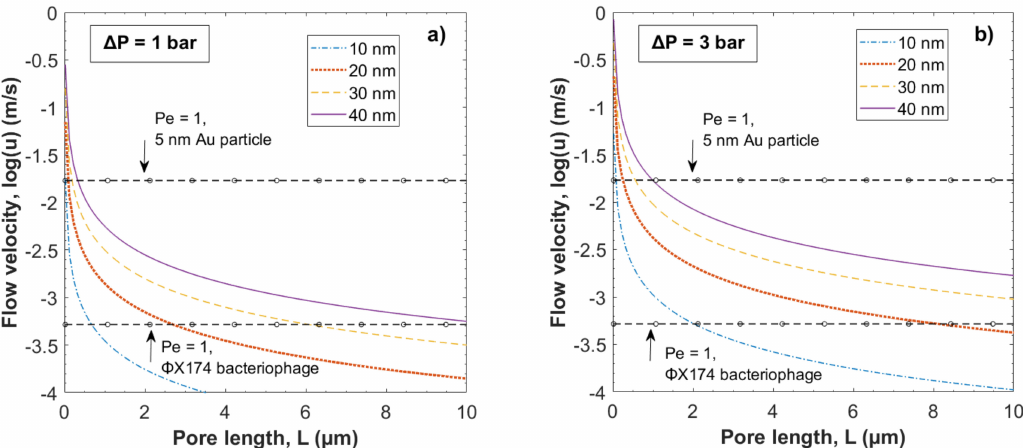
Figure 4. Local flow velocity, log u , as a function of pore length L at four different pore widths, i.e., 10, 20, 30 and 40 nm and pressures ( a ) 1 bar and ( b ) 3 bar. Dashed lines with circles indicate Pe = 1, i.e., u = u cr for the 5 nm gold particles and the 28 nm Φ X174